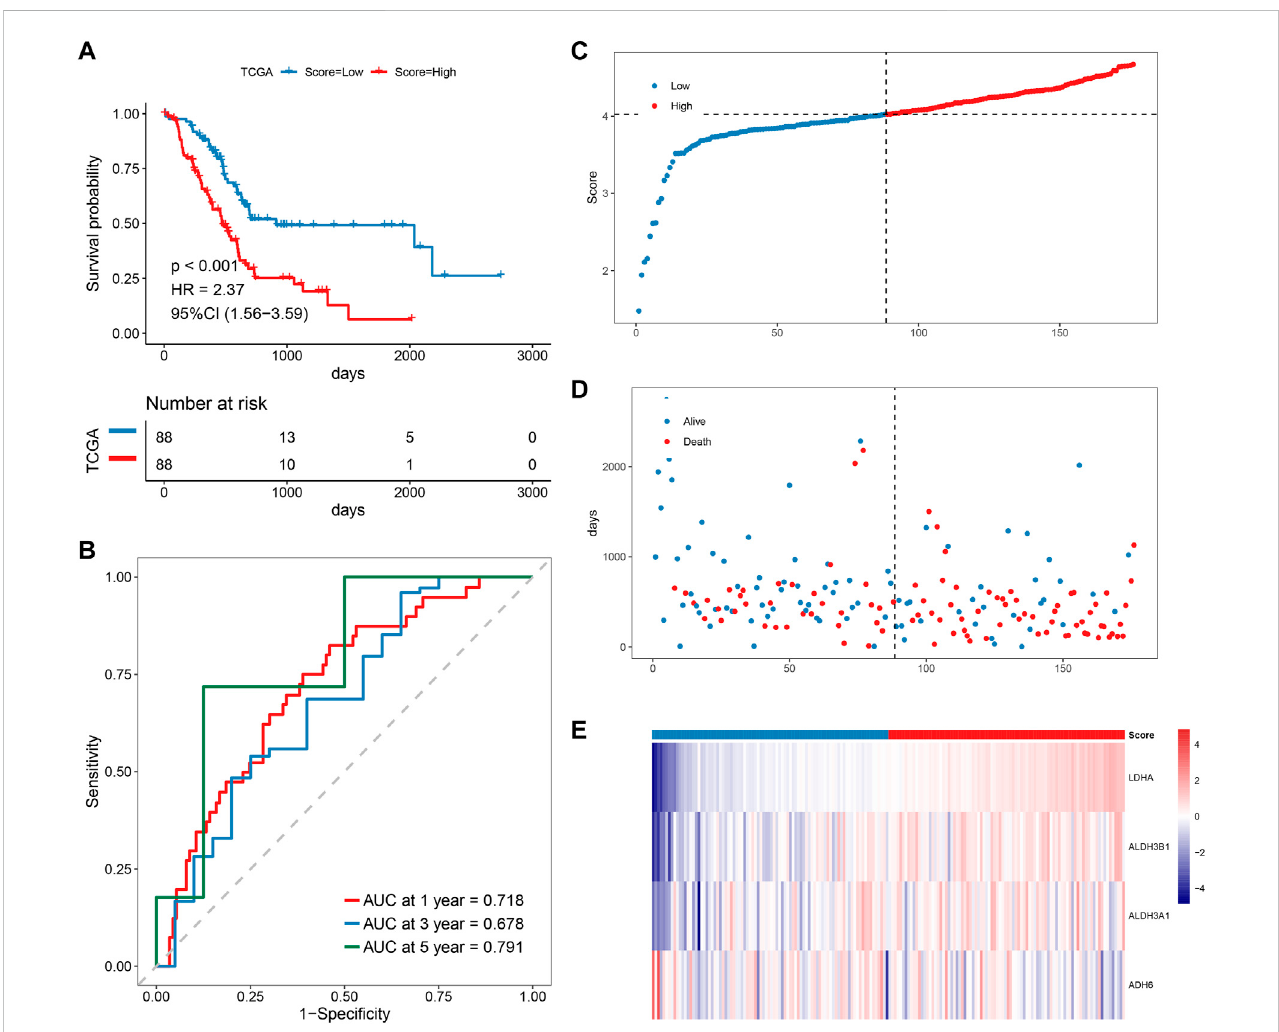
FIGURE 5 Prognostic analysis of MMRG core gene signature. (A – E) KM, ROC, risk score, survival time distribution, and expression of prognostic factors of MMRG core gene